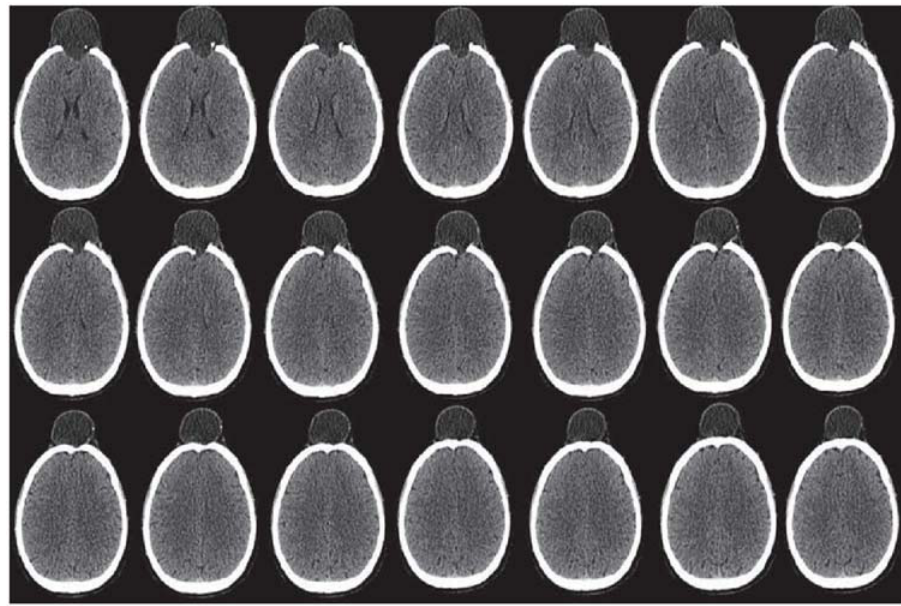
Fig 3. CT scanned images of patient with head injury.